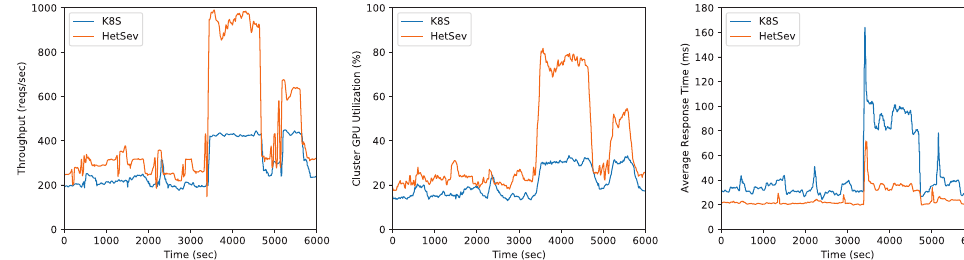
Figure 5. Throughput, cluster GPU utilization and response time under production